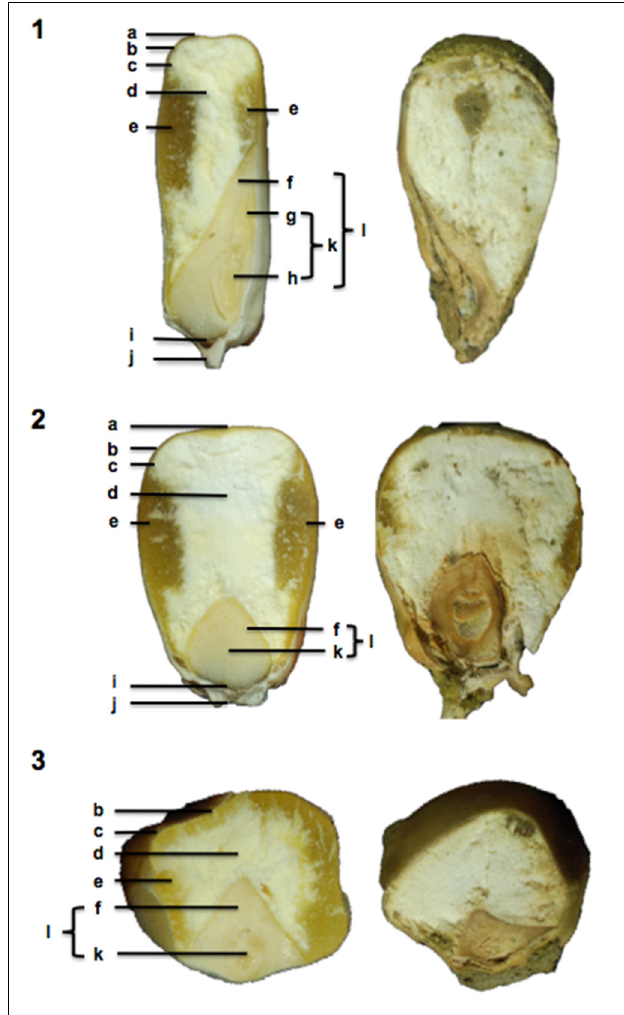
FIGURE 3 | Mature B73 kernels naturally infected with Aspergillus flavus . A sagittal (1) and frontal (2) and transversal (3) section of healthy B73 kernels (left) were compared to disease kernels (right) to discern any physical changes that occurred as a result of A. flavus . Bolded letters denote kernel parts and tissues: a —crown; b —pericarp; c —aleurone; d —starchy endosperm; e —hard endosperm; f —scutellar tissue; g —leaf primordia (plumule); h —primary root; i —transfer cells; j —pedicel; k —embryo; and l